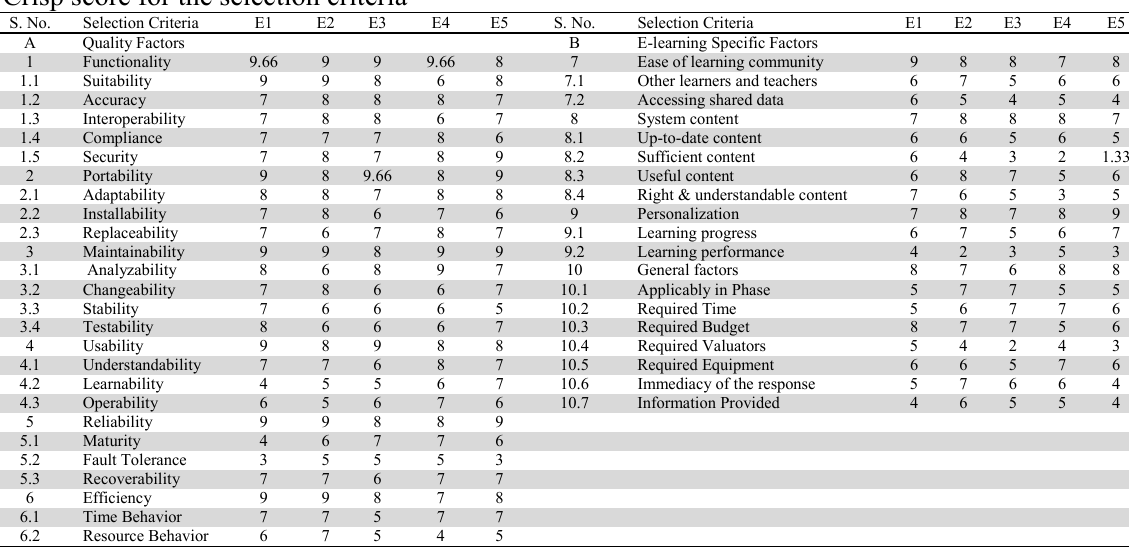
Fig. 1. Hierarchical structure of E-learning websites selection criteria Crisp score for the selection criteria S.